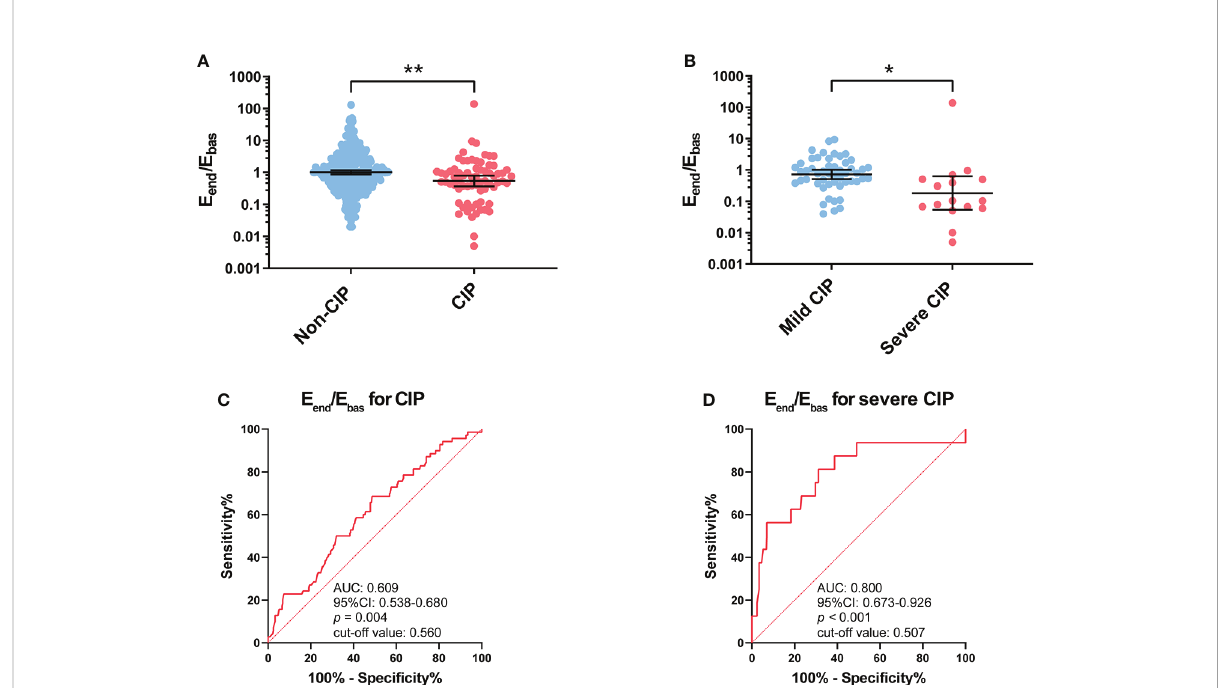
FIGURE 2 Association between E end / E bas value and occurrence of CIP and severe CIP. (A) E end / E bas value between patients with and without CIP. Bars indicate the geometric mean and 95%CI. Unpaired t -test. ** p < 0.01. (B) E end / E bas value between patients with mild and severe CIP. Bars indicate the geometric mean and 95%CI. Welch ’ s t -test. * p < 0.05. (C) ROC curve analysis of the sensitivity and speci fi city of E end / E bas value to distinguish patients with CIP and without CIP (sensitivity, 52.2%; speci fi city, 68.3%; p = 0.004). (D) ROC curve analysis of the sensitivity and speci fi city of E end / E bas value to distinguish patients with severe CIP and without severe CIP (sensitivity, 81.3%; speci fi city, 68.8%; p < 0.001). E end / E bas , eosinophil percentage fold change from the baseline to the endpoint; CIP, checkpoint inhibitor pneumonitis; CI, con receiver operating